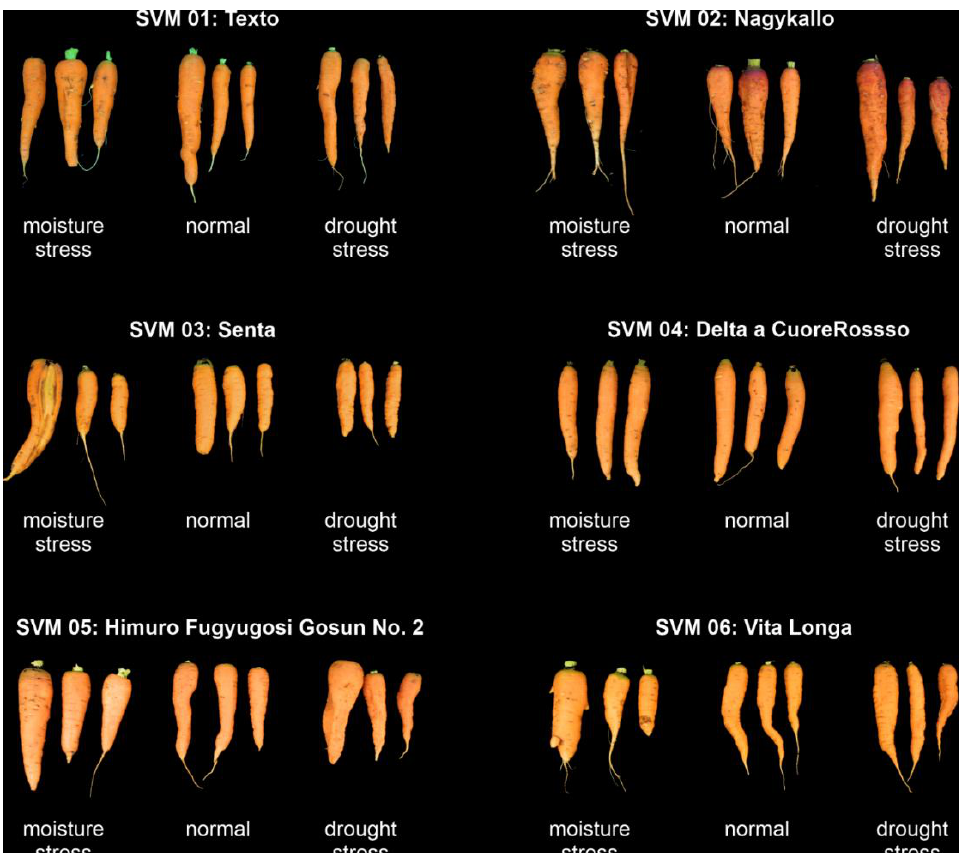
Figure 2. Roots ’ expression of water-stressed carrot cultivars using the rain-out-shelter experiment. Figure 2. Roots’ expression of water-stressed carrot cultivars using the rain-out-shelter